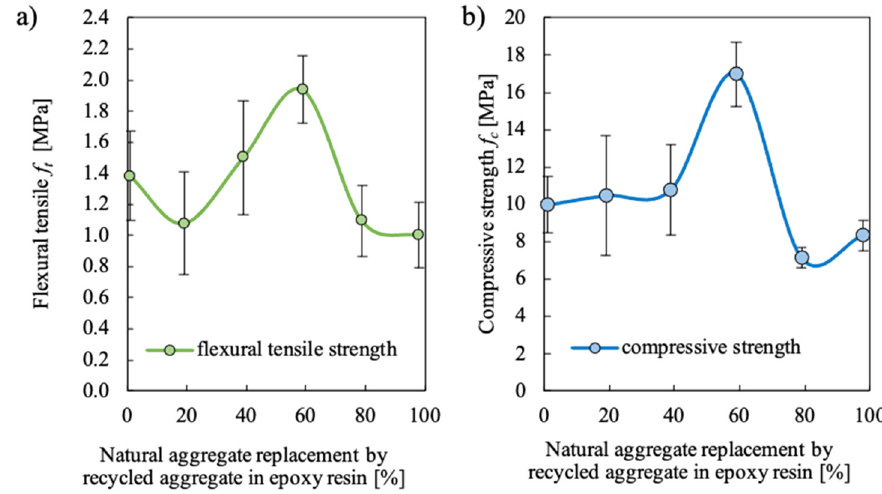
Figure 7: Test results of: ( a ) fl exural tensile strength; ( b ) compressive